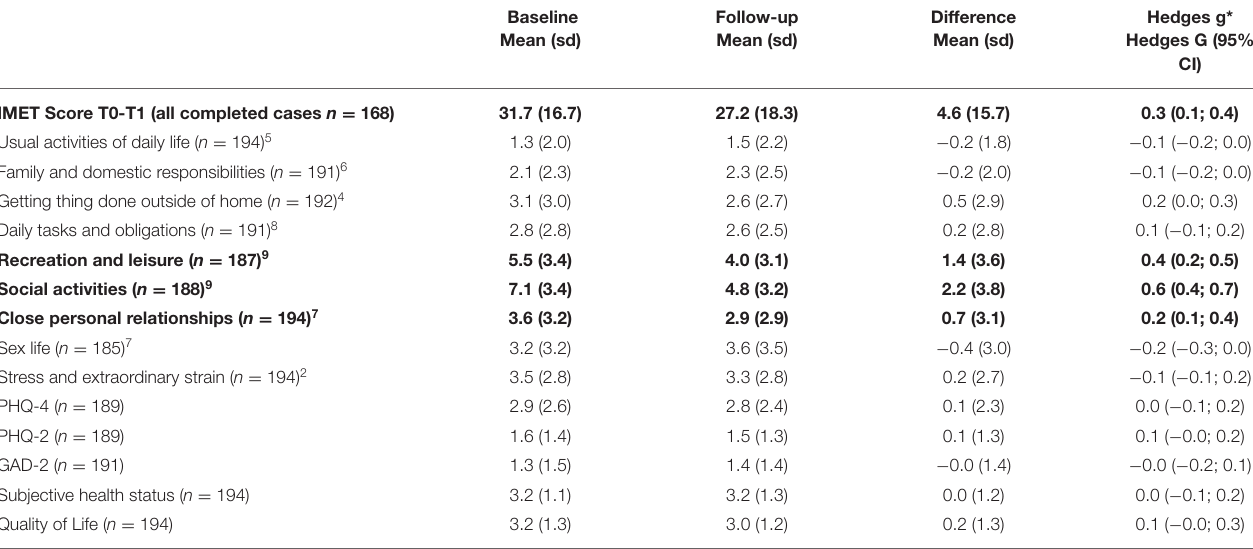
Bold :significantchangebetweenbaselineandfollow-upbetweenusingapairedt-test(p < 0.05oradjustedafterBonferroniwhiletestingsubscales);Hedgesg * biascorrectedforsmall sample size; sd: standard deviation; IMET, Index for the Assessment of Health Impairments; PHQ-4, Patient Health Questionnaire-4; PHQ-2, Patient Health Questionnaire-2; GAD-2, Generalized Anxiety Disorder Scale-2; superscript indicating targeted ICF domain.